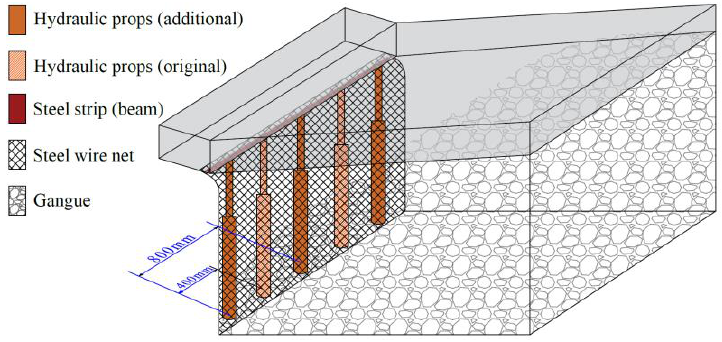
Figure 12. Schematic diagram of gangue retaining.